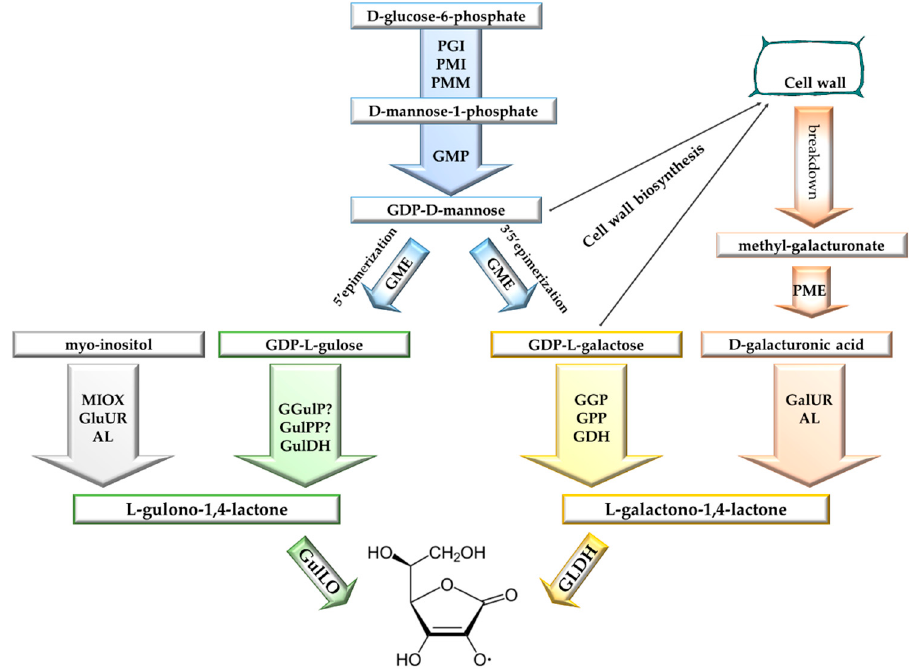
Figure 2. Schematic representation of vitamin C biosynthetic pathways. Different colors indicate different pathways. In grey, the myoinositol pathway; in green, the gulose pathway; in yellow, the D -mannose/ L -galactose pathway; in orange, the galacturonate pathway. Represented in blue are the initial steps leading to GDP- D -mannose, which is a common precursor to the D -mannose/ L -galactose and gulose pathways. A question mark indicates enzymes not identified in plants (more details are provided in the text). Abbreviations: AL, aldono lactonase; GalUR, D -galacturonate reductase; GDH, L -galactose dehydrogenase; GGP, GDP- L -galactose-phosphorylase; GGulP, GDP- L -gulose pyrophosphatase; GLDH, L -galactono-1,4-lactone dehydrogenase; GluUR, glucuronate reductase; GME, GDP- D -mannose epimerase; GMP, GDP- D -mannose pyrophosphorylase; GPP, L -galactose-1-phosphate phosphatase; GulDH, L -gulose dehydrogenase; GulPP, L -gulose-1-phosphate phosphatase; GulLO, gulonolactone oxidase; MIOX, myoinositol oxygenase; PGI, phosphoglucose isomerase; PME, pectin methyl esterase; PMI, phosphomannose isomerase; PMM, phosphomannose mutase.